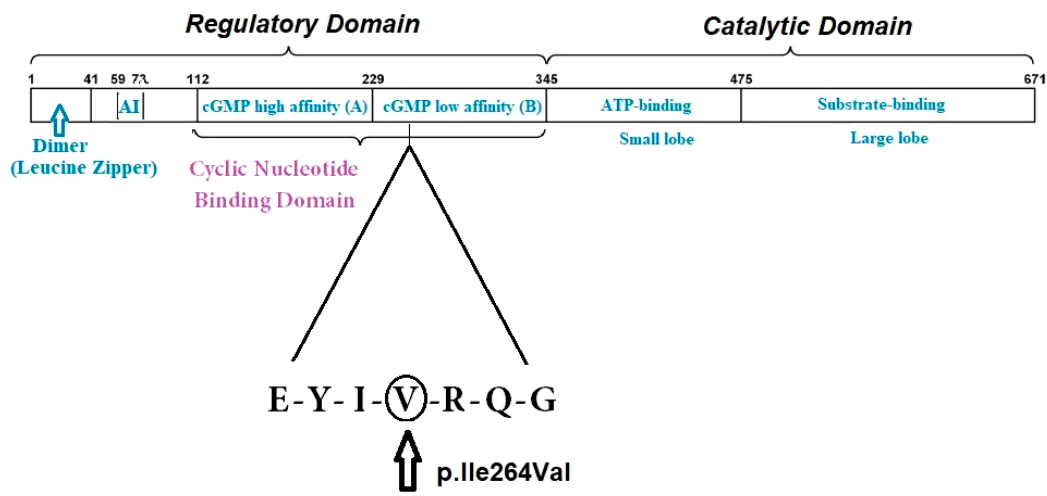
Figure 6. A graphic illustration of the functional domain structure of PKG-1 β and the region where the missense variant p.Ile264Val is located, as indicated by the triangle. At the N-terminus, the dimerization domain (with the Leucine Zipper region) is depicted. AI = the auto-inhibition domain; cGMP high (called A) = the high-affinity binding domain for cGMP; cGMP low (called B) = the low-affinity binding domain for cGMP.